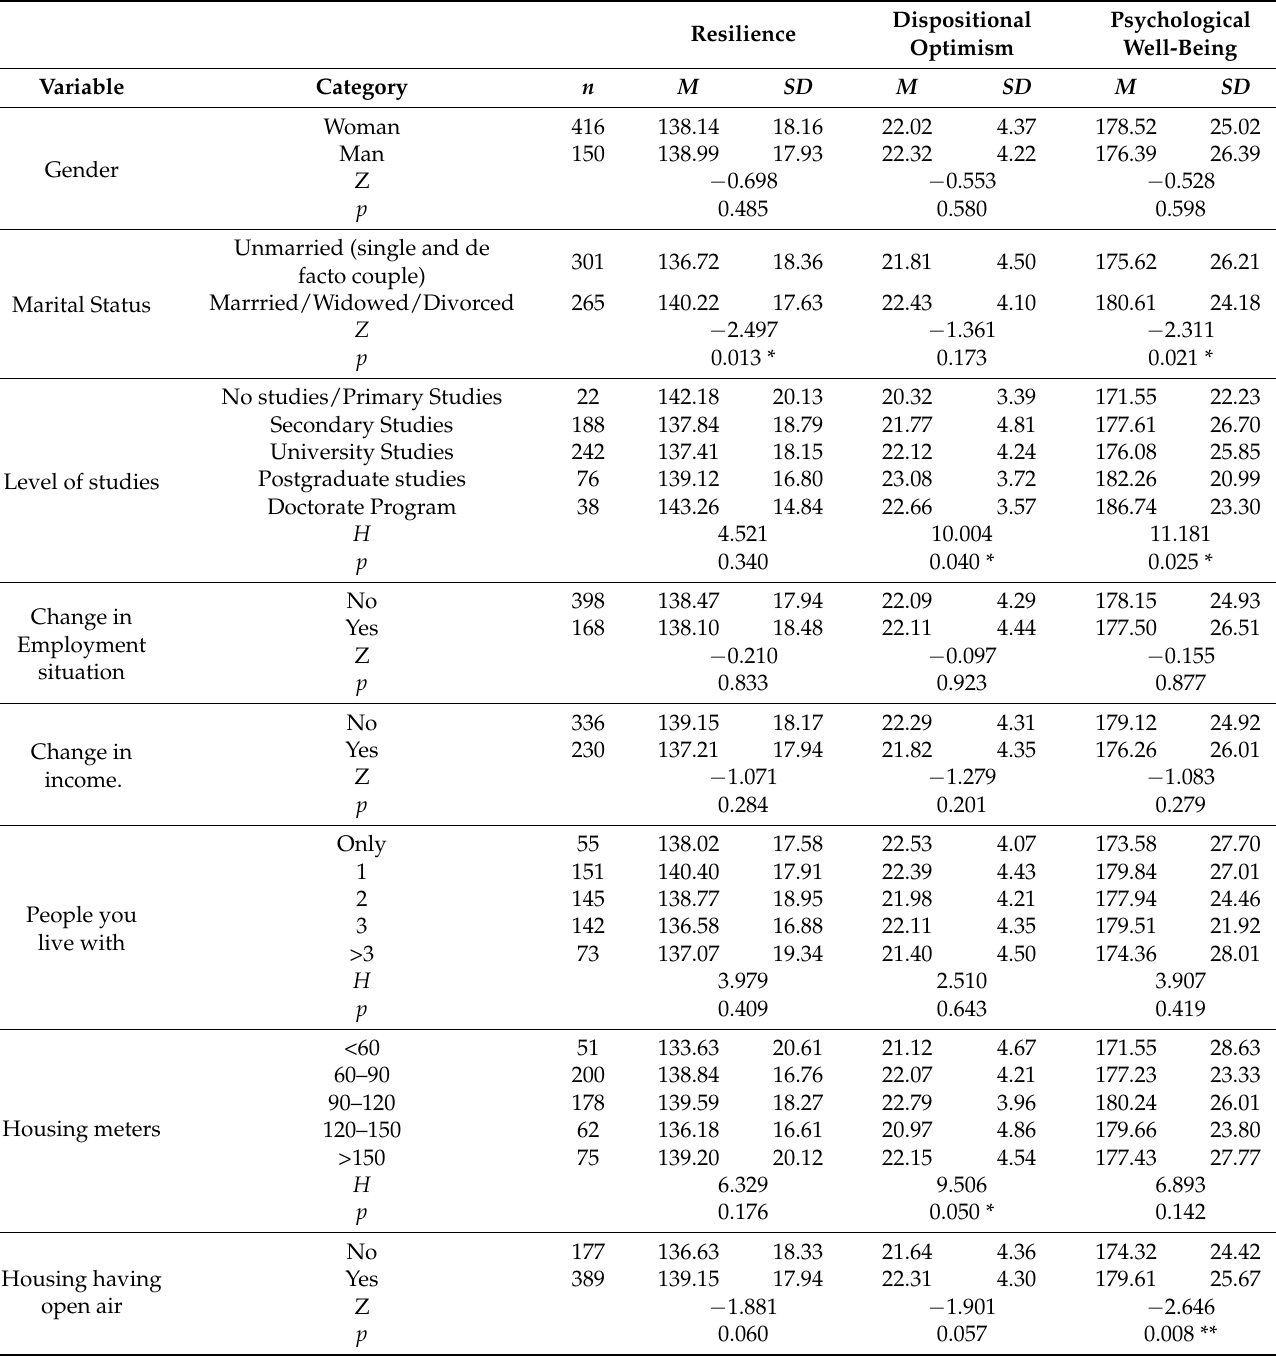
Table 2. Descriptive statistics (means and standard deviations) and statistics (Mann–Whitney U test/Kruskal–Wallis H test) for resilience, dispositional optimism, and psychological well-being for different economic and socio-demographic